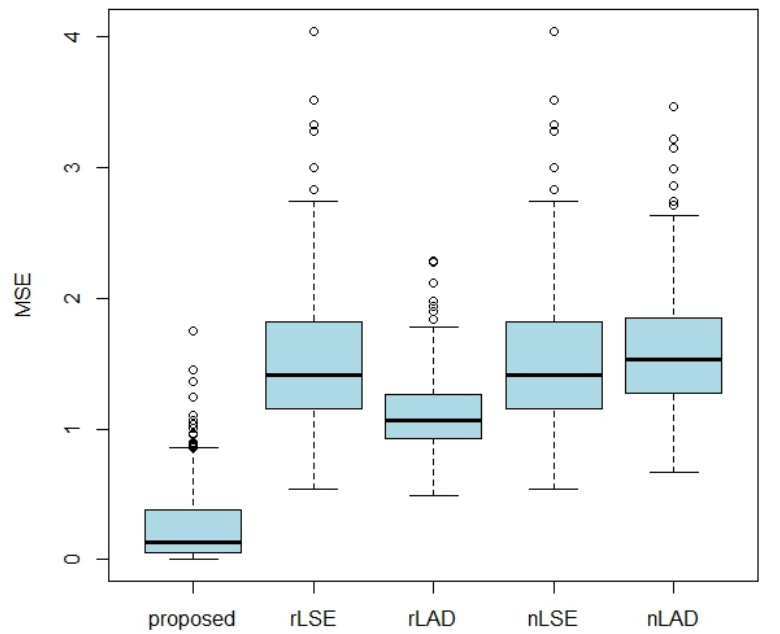
Figure 2. MSE of estimated coefficients of five methods in simulation 1. The five methods are our proposed method(proposed), the naive LSE(nLSE), the naive LAD(nLAD), the rank LSE(rLSE) and the rank LAD(rLAD).